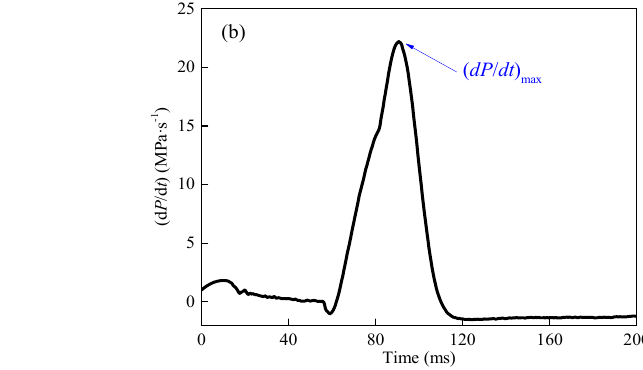
Figure 3. The explosion pressure ( a ) and the fi rst-order derivative of the explosion pressure ( b ).